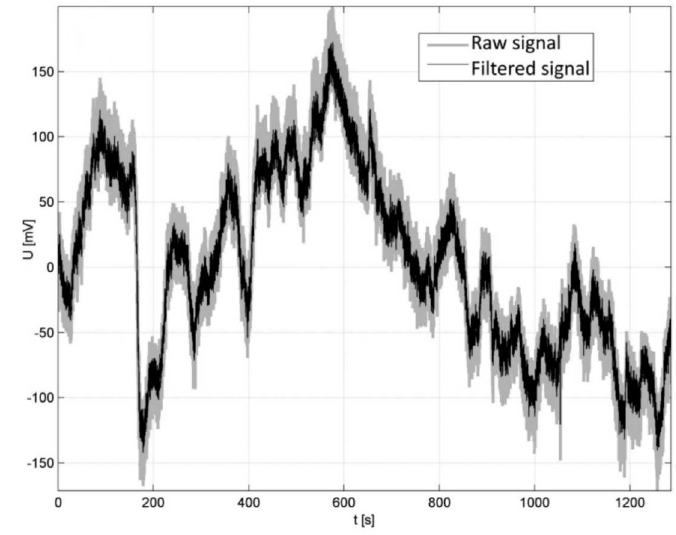
Figure 2. Time series in the C3 point (sample 1)